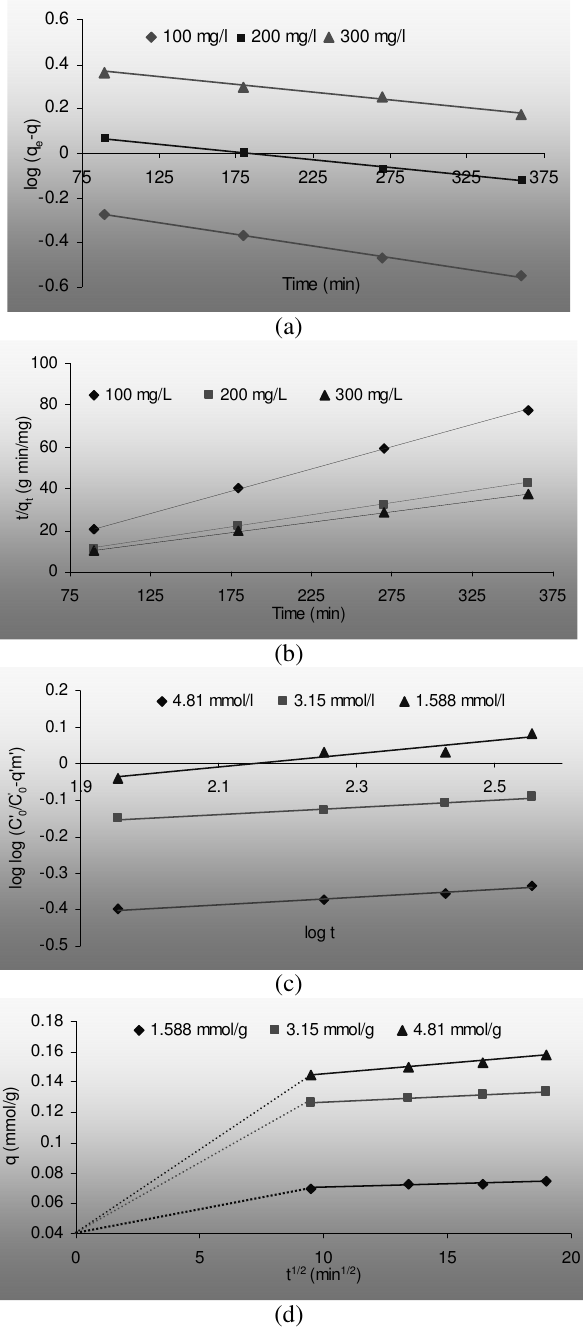
Figure 7. (a) Lagergren’s plot, (b) Pseudo second order plot, (c) Bangham’s plot, and (d) Weber and Morris plot for dynamic study of Cu +2 sorption on